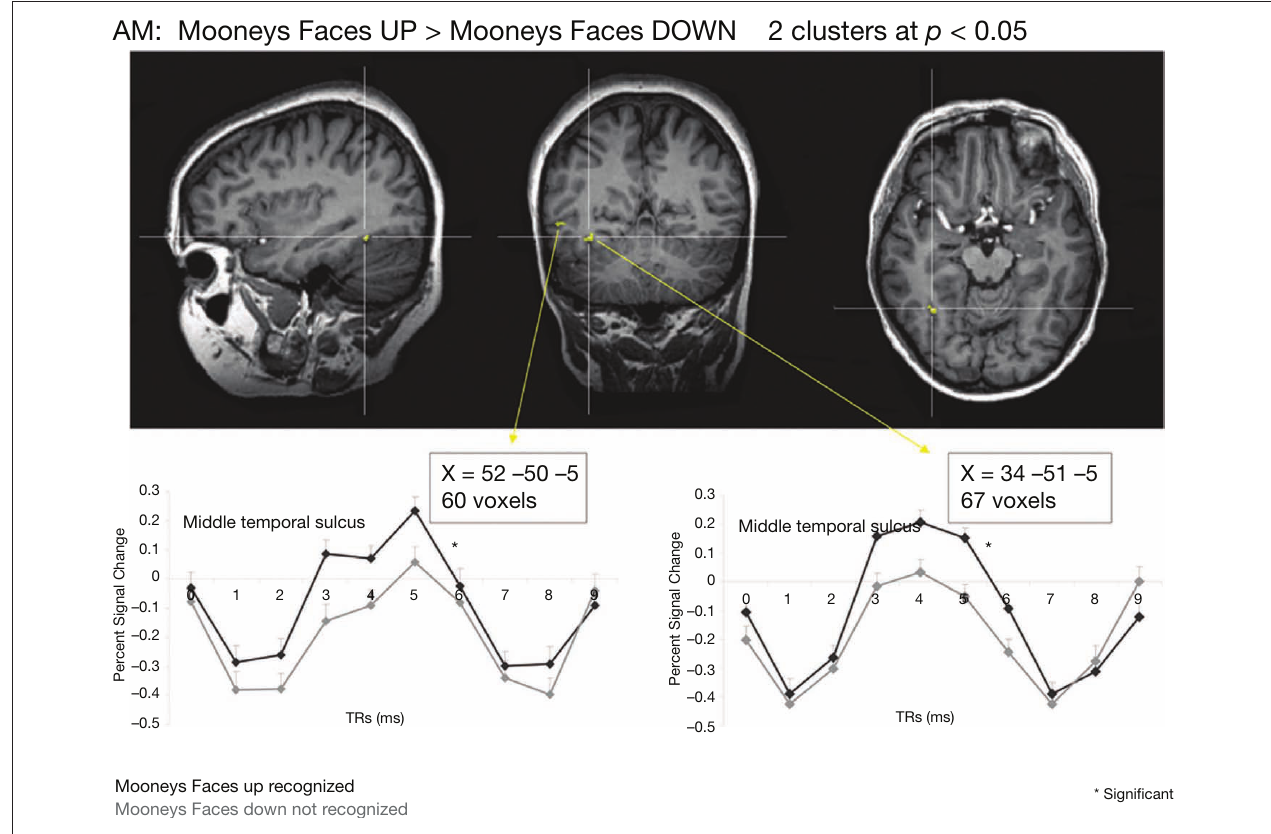
Figure 8 | Whole-brain analysis performed on the age-matched control (AM) in the Mooney face categorization experiment. As for the patient PS, two areas were found to be significant, one corresponding roughly to the right FFA, presenting face-preferential response to faces in the localizer experiment, and the other one in the middle temporal sulcus, which did not show a preferential response to faces in the localizer